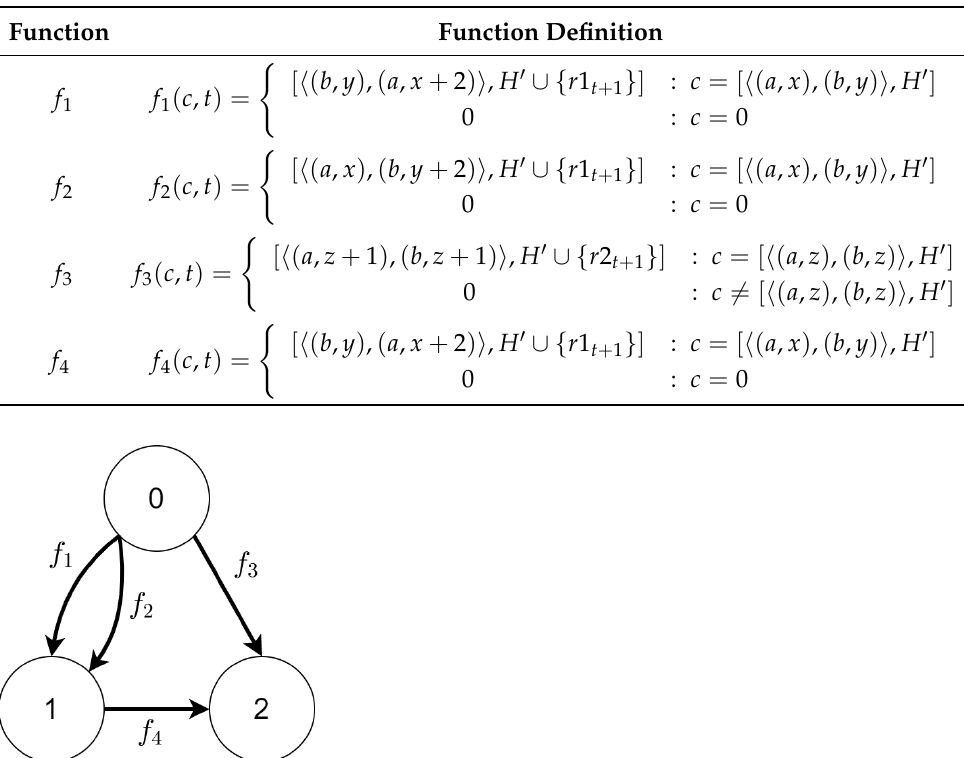
Table 4. Mission progress function definitions for the state space presented in Figure 2. The action represented by r 1 reaction rule is assumed to take 2 units of time while the action r 2 takes only 1 unit of time.